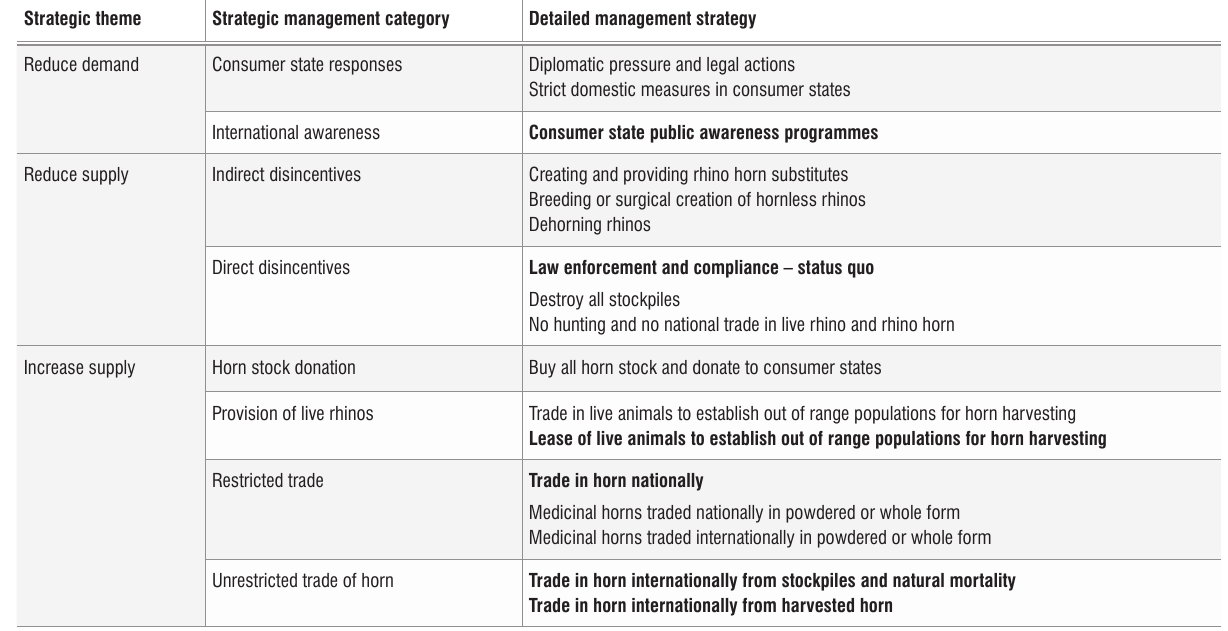
Table 3. Categorisation of the 17 proposed alternative detailed rhino management strategies Strategic theme Strategic management